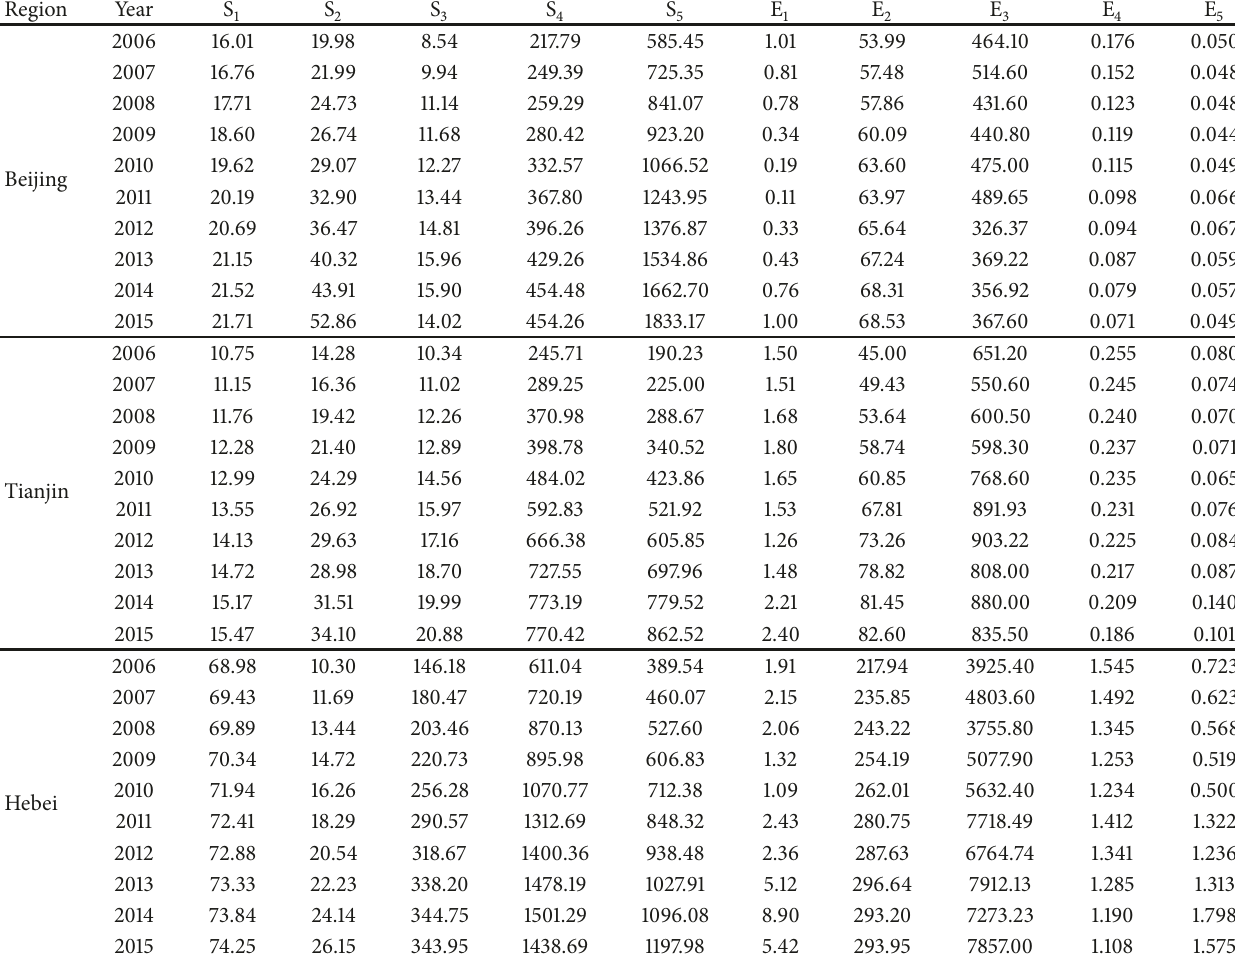
Table 2: Selected data of the three regions for each indicator during 2006–2015.